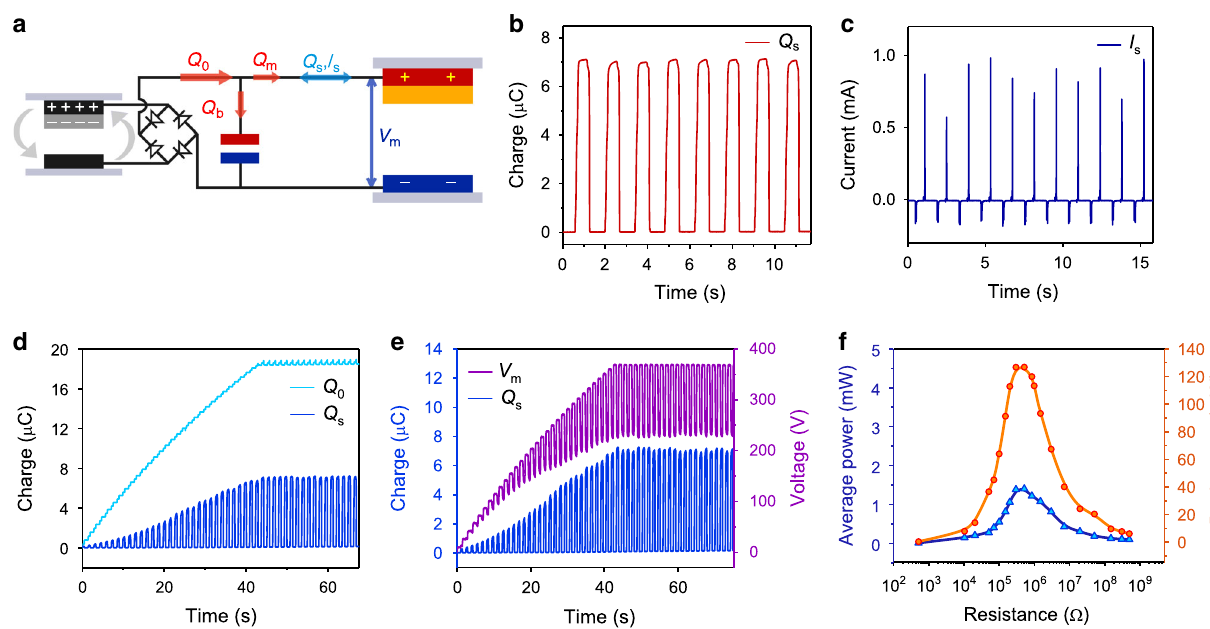
Fig. 3 Electrical characteristics of the CS-TENG. a Electrical circuit diagram of the experiments. b , c Shuttled charges ( b ) and corresponding current ( c ) of the CS-TENG. d Shuttled charges and simultaneously injected charges of the CS-TENG. e Shuttled charges and simultaneous voltage of the CS-TENG. f Peak power and average power of the CS-TENG under various loads. Source data are provided as a Source Data fi